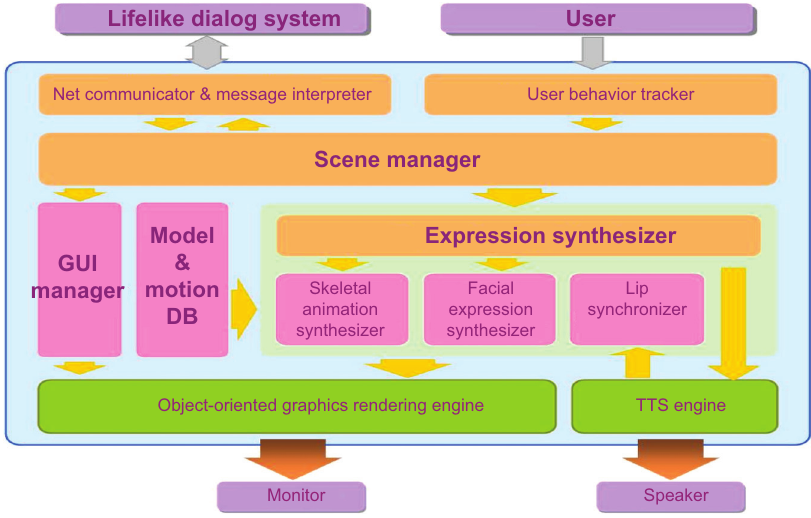
Figure 4. LifeLike Responsive Avatar Framework.